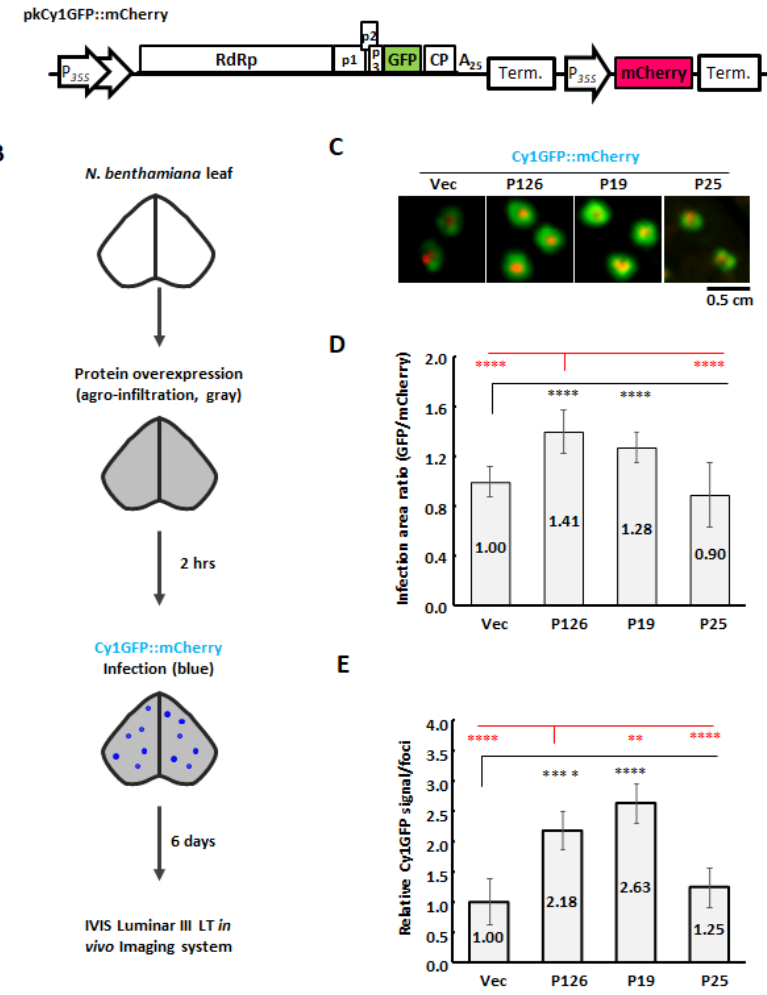
Figure 5. CymMV cell-to-cell movement and accumulation upon overexpressing VSRs in N. benthamiana leaves. ( A ) Schematic construct of pkCy1GFP::mCherry. ( B ) Flowchart for protein expression and CymMV inoculation. Agrobacterium carrying pBIN61 (Vec), pBIN61-P126 (P126), pBIN19-P19 (P19) or pBIN61-P25 (P25) were adjusted to OD 600 = 0.5 and then infiltrated into 17-day-old N. benthamiana leaves. After 2 hours post-agroinfiltration, the Agrobacterium ooze carrying pkCy1GFP::mCherry was collected on a toothpick and pinpricked onto the infiltrated leaves. ( C ) Representative images of Agrobacterium primary infection sites (mCherry in red) and Cy1GFP spreading infected cells (GFP in green) using the IVIS Lumina III LT in vivo Imaging System at 6 DPA. Images were processed in ImageJ. ( D ) Quantification of CymMV movement. According to ( C ), the ratio of coverage areas was measured by the expanded Cy1GFP signals (GFP) against primary infection site (mCherry). ( E ) Effects of VSRs on accumulation of Cy1GFP. The relative Cy1GFP signals were measured by the total GFP signals per infection foci and quantification was normalized to vector control (black star) or P126 (red star). Data represent three experimental replicates, each of which encompassed analysis of six infection foci. Significant differences are marked as follows: **: p < 0.01 and ****: p < 0.0001 (one-way ANOVA followed by post-hoc test). In order to evaluate the function of P126 protein in CymMV cell-to-cell movement, we overexpressed P126 protein or vector control in N. benthamiana leaves, followed by agro-infection of Cy1GFP::mCherry by using a toothpick (Figure 5B). Expanded Cy1GFP signal could be observed at 6 DPA (Figure 5C) and the virus spreading was evaluated by measuring the relative signal areas of GFP/mCherry. By comparing the spread of Cy1GFP